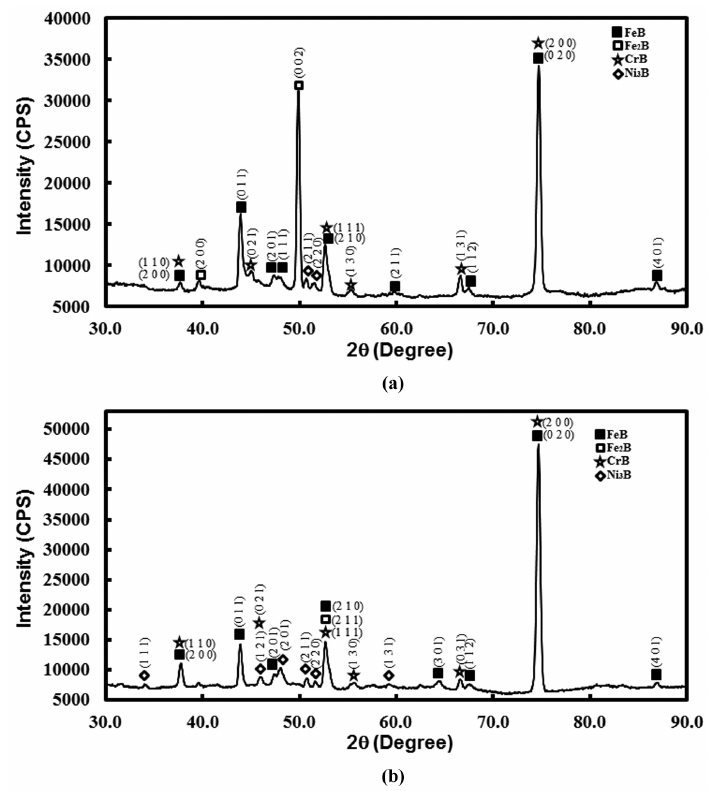
Figure 3. Patterns of X-ray diffraction on AISI 304 borided steel at 1223 K, over (a) 2 h and (b) 10 h of exposure